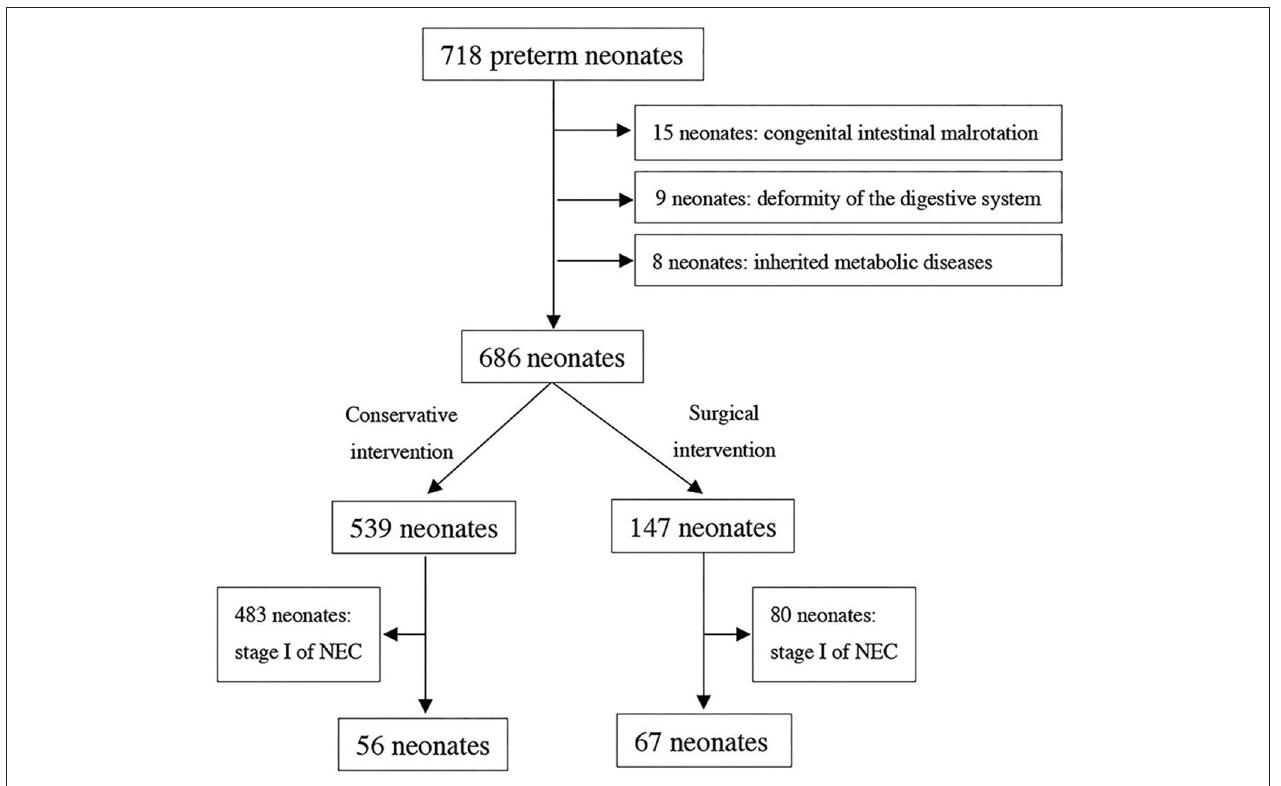
FIGURE 1 | Flow diagram for patient population of necrotizing